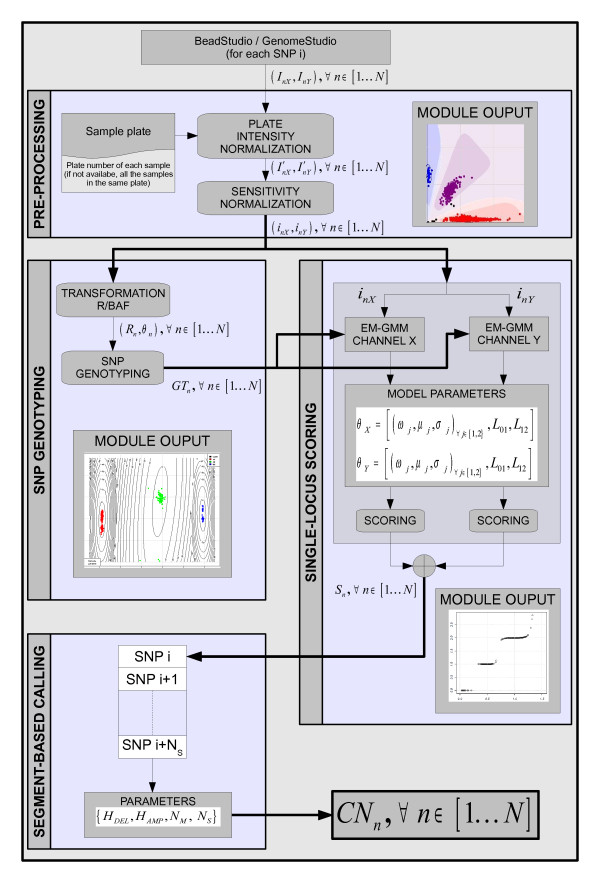
Flowchart of CNstream processing steps. Data processing with CNstream is organized into four functional modules: Pre-processing, SNP genotyping, Single-locus scoring and Segment-based calling.